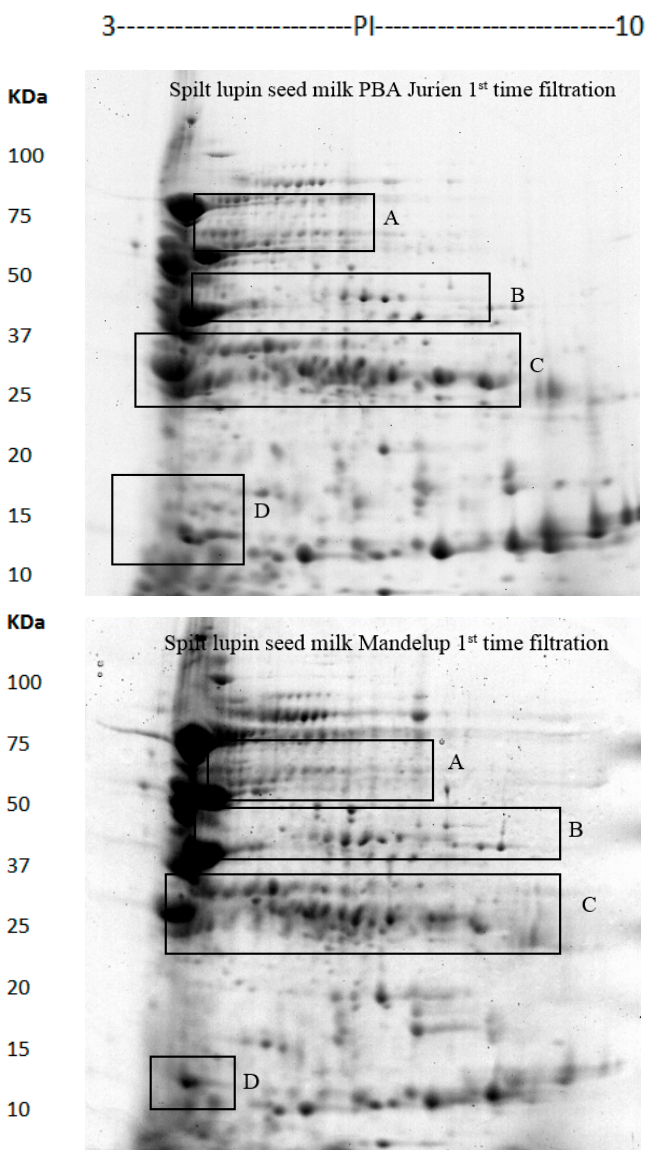
Figure 2. Lupin milk protein from split lupin with the first and second filtrations of two cultivars of L. angustifolius, as demonstrated by two-dimensional gel electrophoresis.